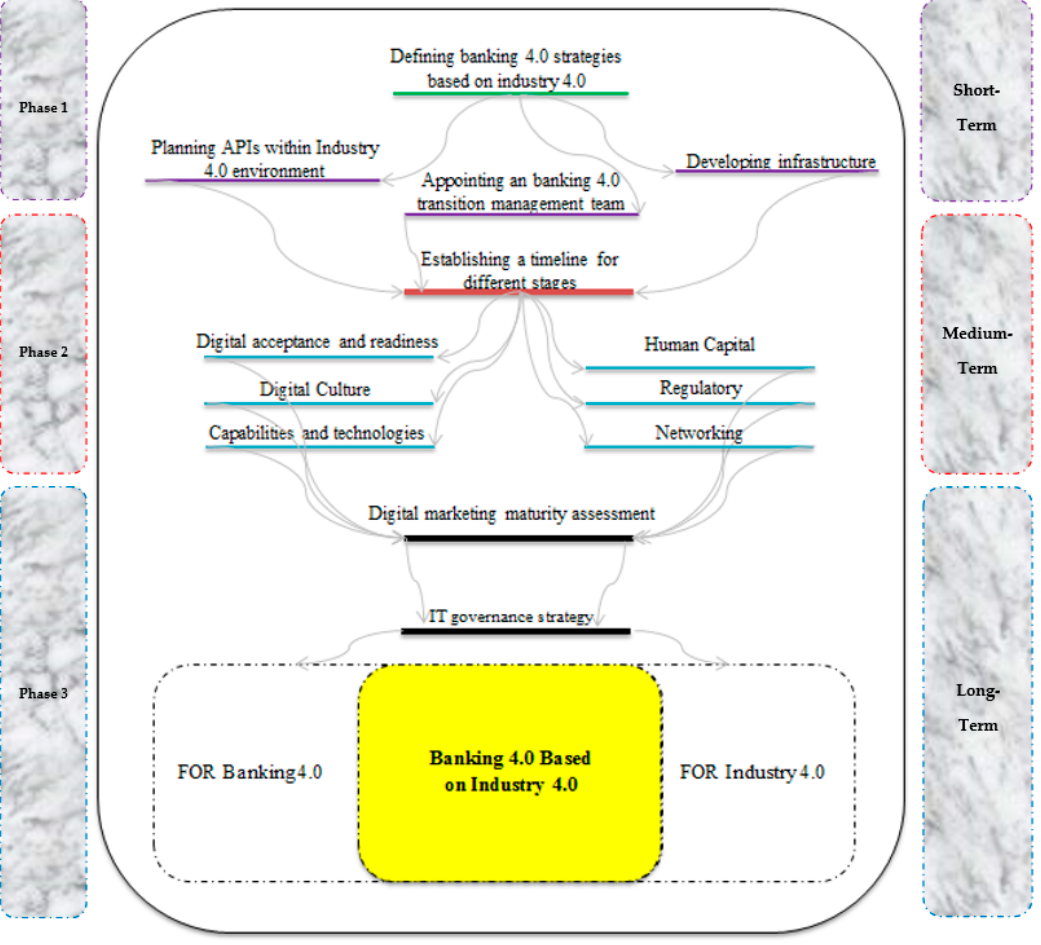
Figure 15. The strategic roadmap for Banking 4.0 based on Industry 4.0. Source: Own contribution of the authors.